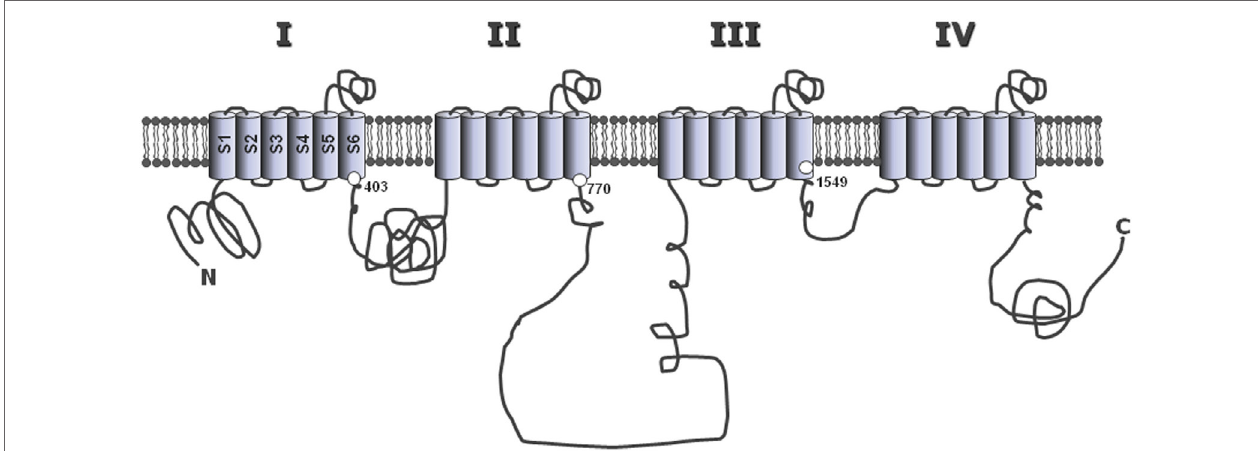
FiGURe 2 | Common structure of the alpha 1 subunit of voltage-operated calcium channels . The main, pore-forming α 1 subunits of the various voltage- operated calcium channels share a common general structure, with four homologous repeats (I–IV), each composed of six hydrophobic, putative membrane- spanning alpha helix domains (S1–S6). The three large loops connecting repeats together, as well as the N- and C-terminal extremities are located in the cytosol. The positions of Gly403 and Ile770 mutated in CACNA1D (13), and of Met1549 in CACNA1H (35), are indicated at the end of the S6 segments in repeats I, II, and III, respectively.